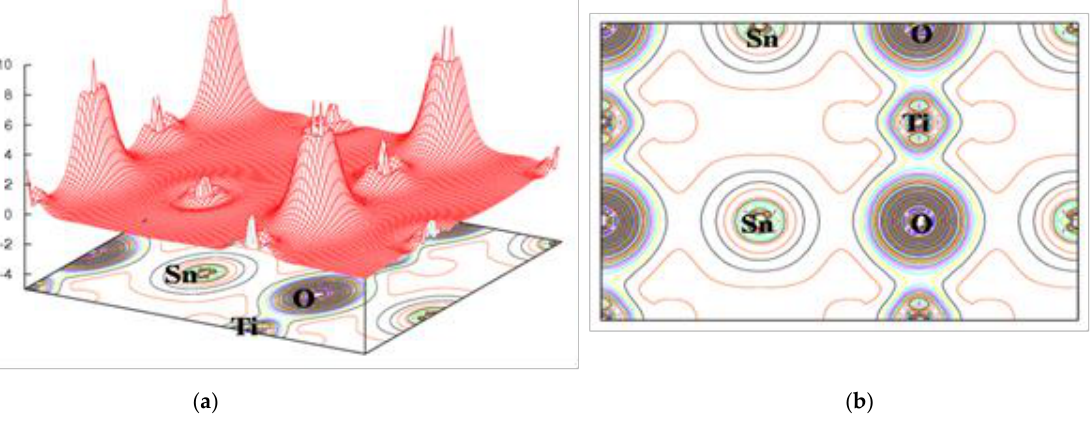
Figure 5. Valence electron charge density contour plot of SnTiO 3 using GGA-mBJ ( a ) (100) plane in 3D representation and ( b ) (110) plane charge density contour plot SnTiO 3 .